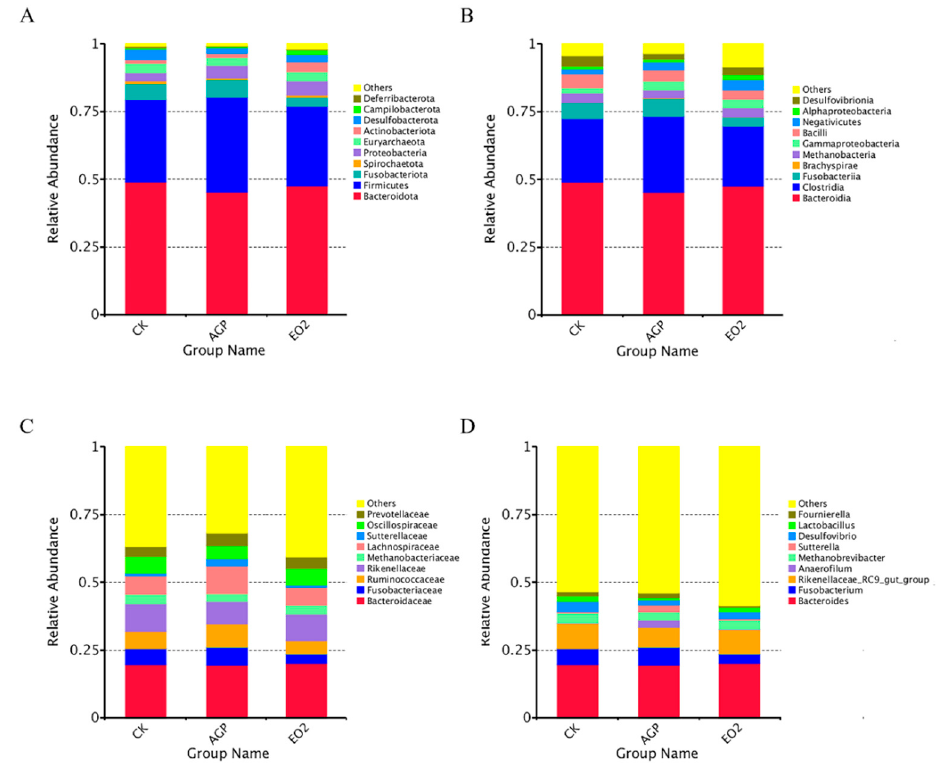
Figure 2. Microbial composition in the cecum of laying hens at phylum level ( A ), class level ( B ), family level ( C ), and genus level ( D ). Control, hens received a basal diet; AGP, hens received a basal diet supplemented with 5 mg/kg flavomycin; EO2, hens received a basal diet supplemented with 200 mg/kg oregano essential oil and 20 mg/kg cinnamaldehyde.